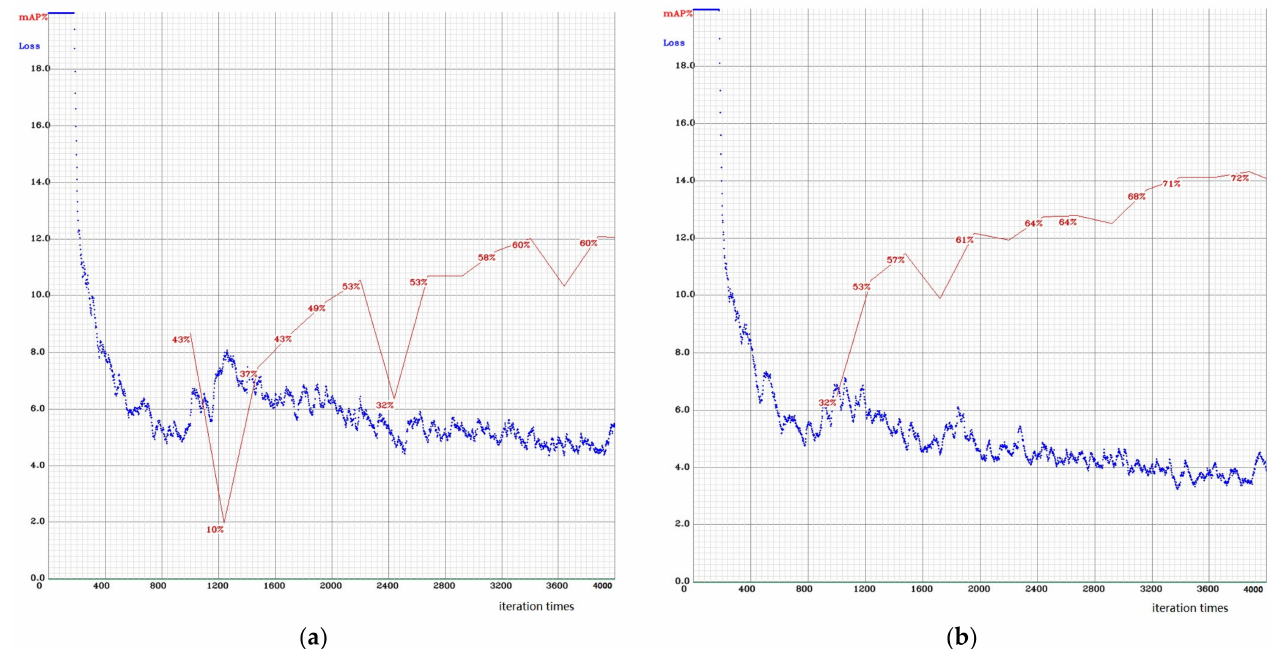
Figure 5. YOLOv4 ( a ) and RepDarkNet-B3 ( b ) loss comparison.